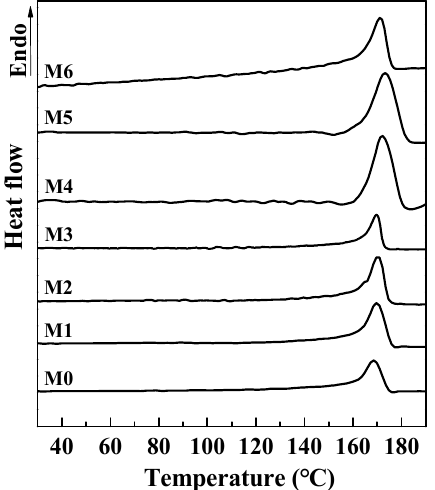
Figure 6. DSC curves of PVDF composited membranes with various amounts of mCNTs grafting single and diblock chains and membranes with oriented or unoriented mCNTs. (The M0, M1, M2, M3, M4, M5 and M6 sample information is listed in Table 1.)